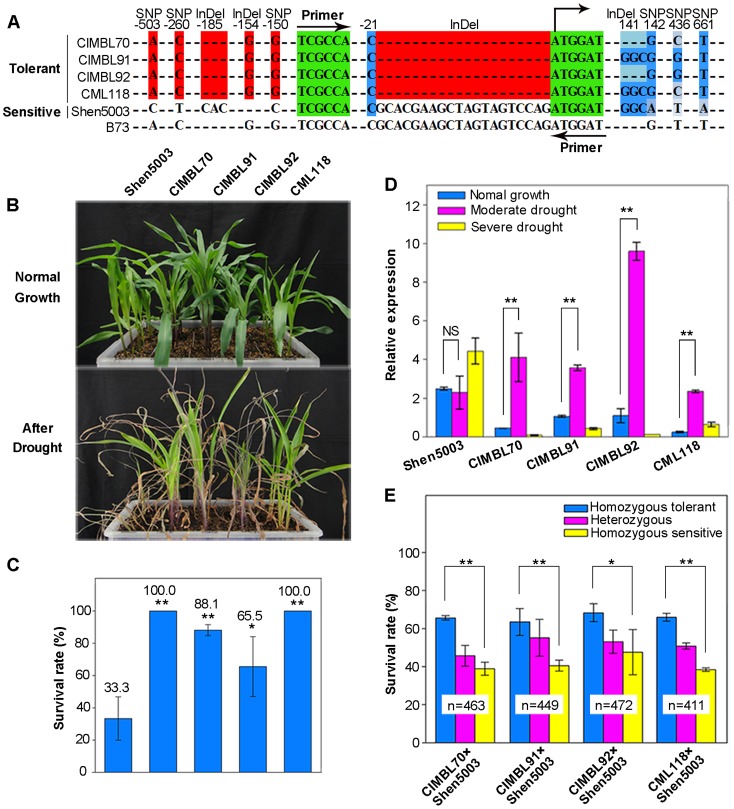
The favorable allele of ZmDREB2.7 improves maize drought tolerance.(A) Haplotypes of ZmDREB2.7 in CIMBL70, 91, 92, CML118, Shen5003 and B73 (as reference genome) maize genotypes. The site of the start codon (ATG) was designated as “+1”. SNP-503, SNP-260, SNP-150, InDel-185 and InDel-154 are the five DNA polymorphisms significantly associated with maize drought tolerance and are located in the 5′-UTR of ZmDREB2.7. The 20-bp InDel upstream of the ATG is in complete LD with the five polymorphisms in the four drought tolerant varieties. These polymorphisms are shaded in red. The location of PCR primers used for genotyping the InDel polymorphism of ZmDREB2.7 in drought tolerant (CIMBL70, 91, 92, and CML118) and drought sensitive (Shen5003) inbred lines are indicated by arrows. The four significant nonsynonymous polymorphisms in the coding region of InDel141, SNP142, SNP436 and SNP661 are shaded in blue. (B) Phenotypic response of CIMBL70, 91, 92, CML118 and Shen5003 to drought stress. The upper panel is a photo of plants growing under favorable water conditions while the lower panel plants re-watered for 6 days after the drought stress treatment was terminated. (C) The survival rate of CIMBL70, 91, 92, CML118 and Shen5003 plants exposed to moderate and severe drought stress. Data represent the mean of triplicates (t-test, *p<0.05, **p<0.01). (D) Relative level of ZmDREB2.7 expression in CIMBL70, 91, 92, CML118 and Shen5003 grown under normal and drought stress conditions. The drought-stress treatment reflected a decrease in RLWC from 98% (unstressed) to 70% (moderate drought), and 58% (severe drought). Data represent the mean of three biological replicates (t-test, **p<0.01). (E) The effect of the ZmDREB2.7 favorable allele on drought tolerance in four F2 segregating populations of maize. In each population, three distinct genotypes for ZmDREB2.7 were identified by DNA amplification: homozygous for the favorable allele, homozygous for the sensitive allele, and heterozygous for both alleles. The survival rate of the different genotypes was assessed and compared in the four populations. N indicates the number of F2 individuals tested in each population (t-test, *p<0.05, **p<0.01).